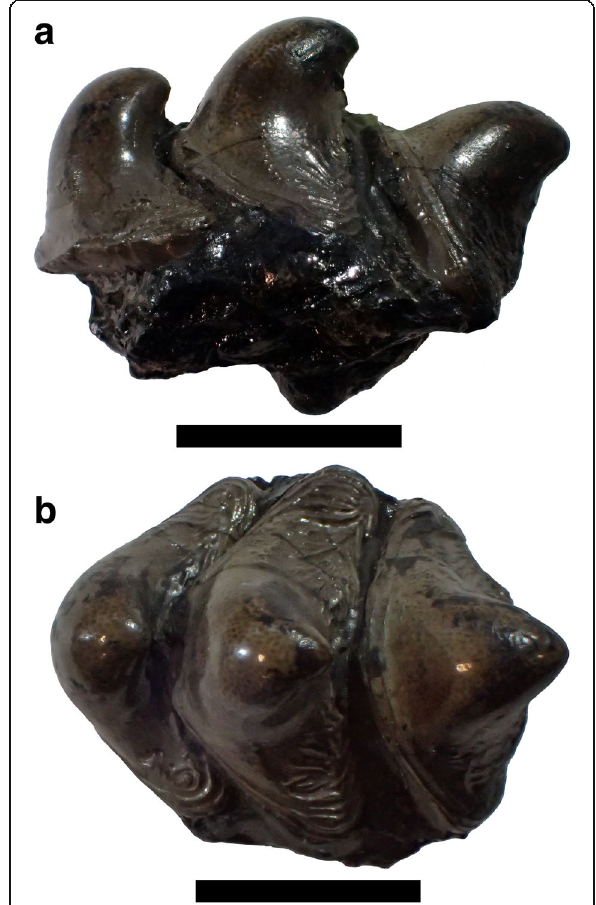
Fig. 2 Tooth file of Helodus simplex Agassiz, 1838 [18]. One of several specimens labeled NHMUK PV P8216. a Lateral view. b occlusal view. Scale bars = 1 cm